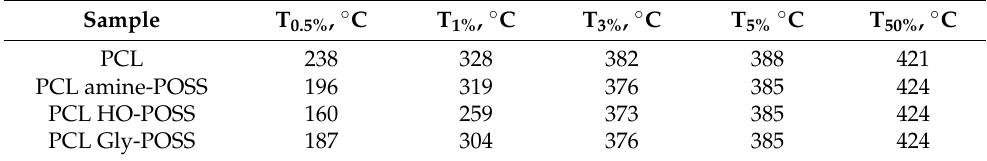
Table 2. TGA analysis of PCL POSS samples.